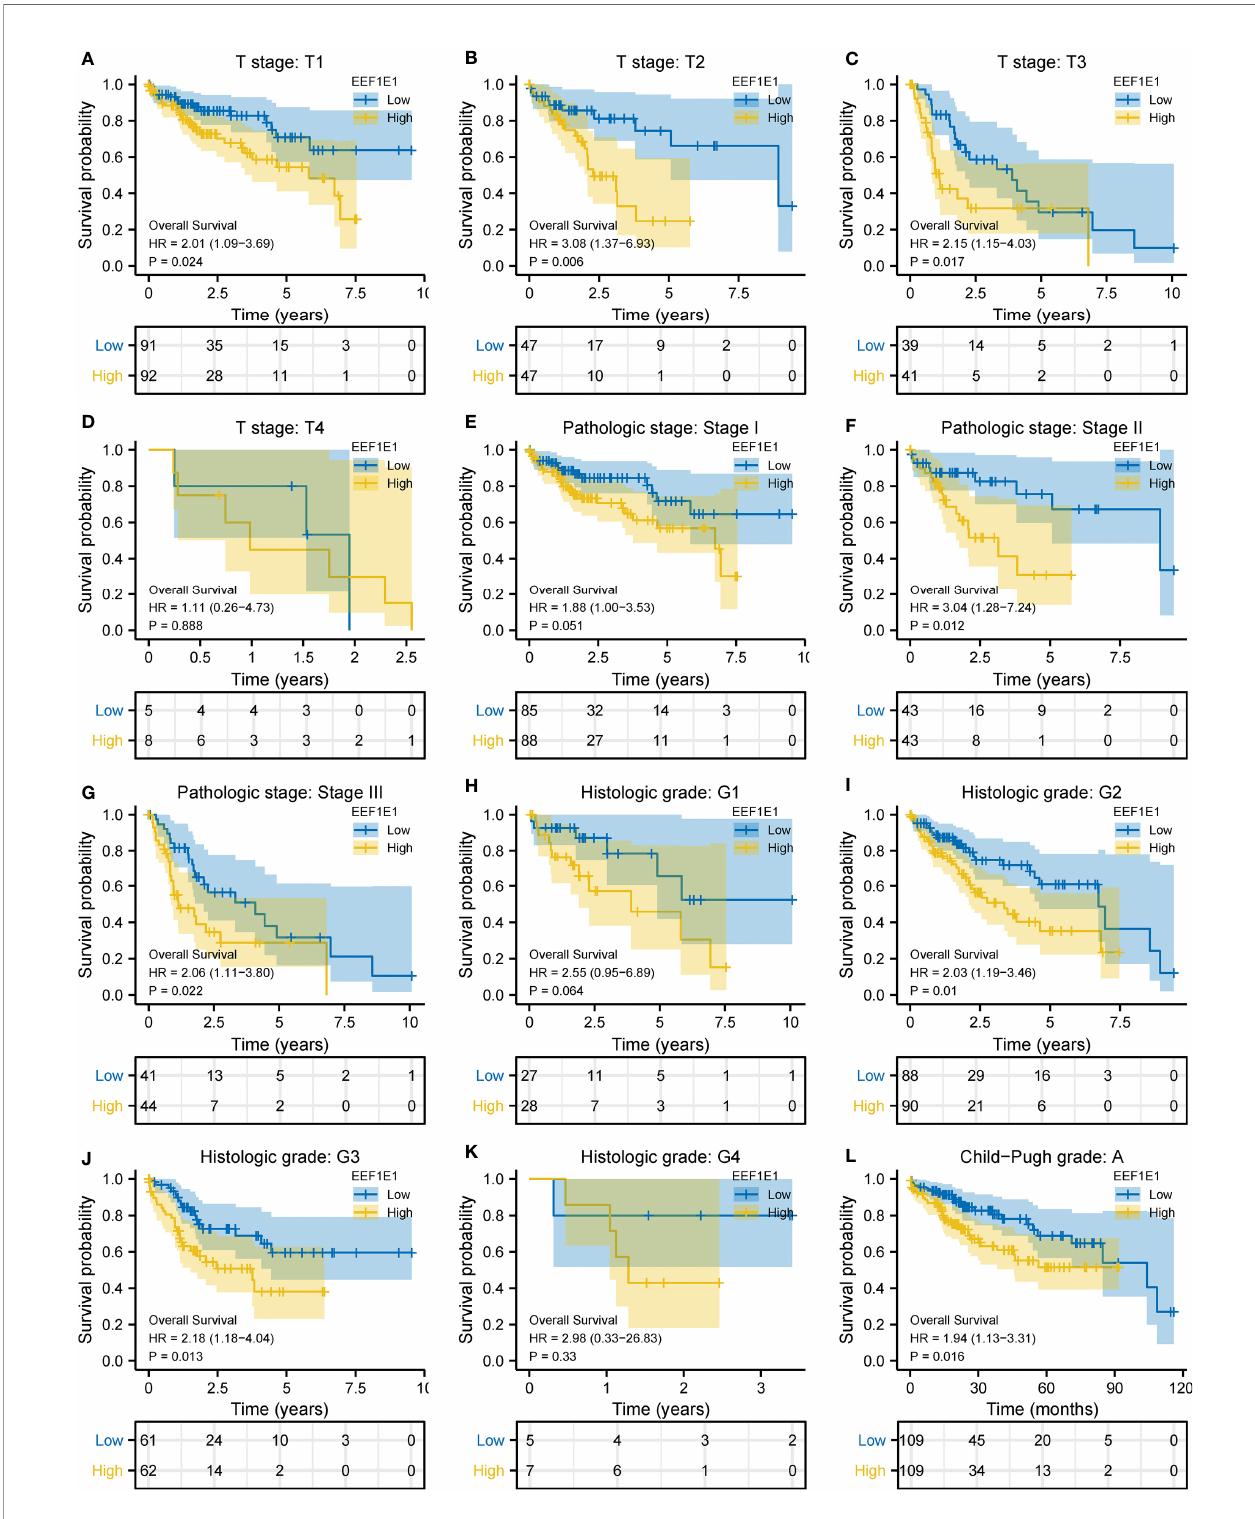
FIGURE 4 | Correlation between EEF1E1 expression and prognosis (continued). (A – D) Effect of differential EEF1E1 expression and T stage on overall survival. (E – G) Effect of differential EEF1E1 expression and pathologic stage on overall survival. (H – K) Effect of differential EEF1E1 expression and histologic grade on overall survival. (L) Effect of differential EEF1E1 expression and Child-Pugh grade on overall